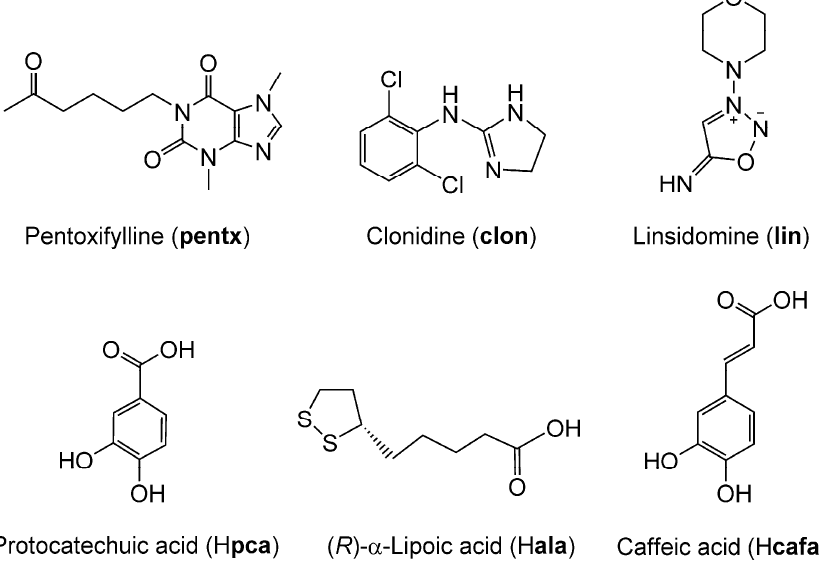
Figure 1. Molecular structures of pentoxifylline ( pentx ), clonidine ( clon ), linsidomine ( lin ), protocatechuic acid (H pca ), ( R )- α -lipoic acid (H ala ) and caffeic acid (H cafa ).